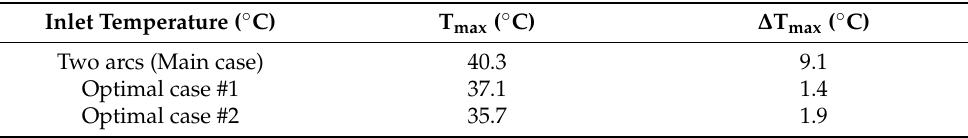
Table 9. The thermal performance of the system for the optimal